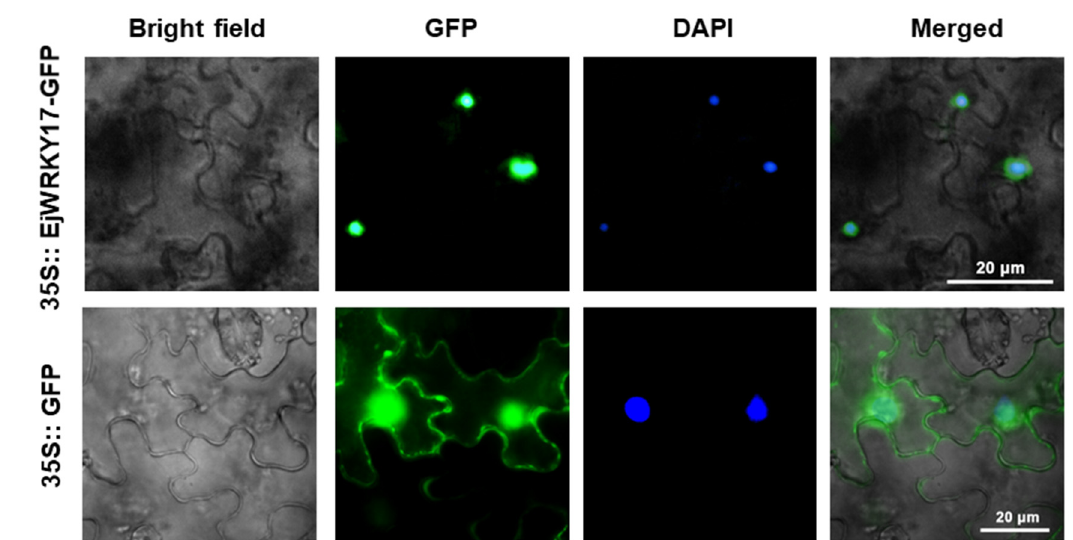
Figure 2. The subcellular localization of EjWRKY17 in N . benthamiana epidermal cells. GFP: Green fluorescence protein. DAPI: Nucleic marker. Merged: Merged image of bright field, GFP, and DAPI.